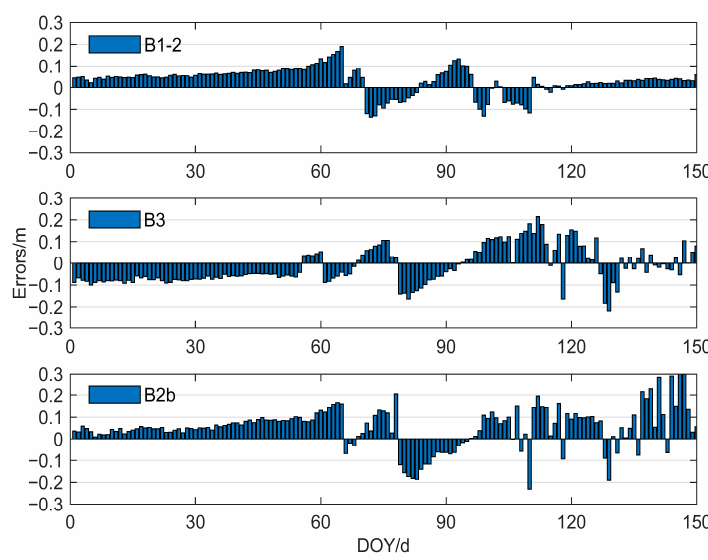
Figure 16. Retrieval errors of wheat height with BDS.